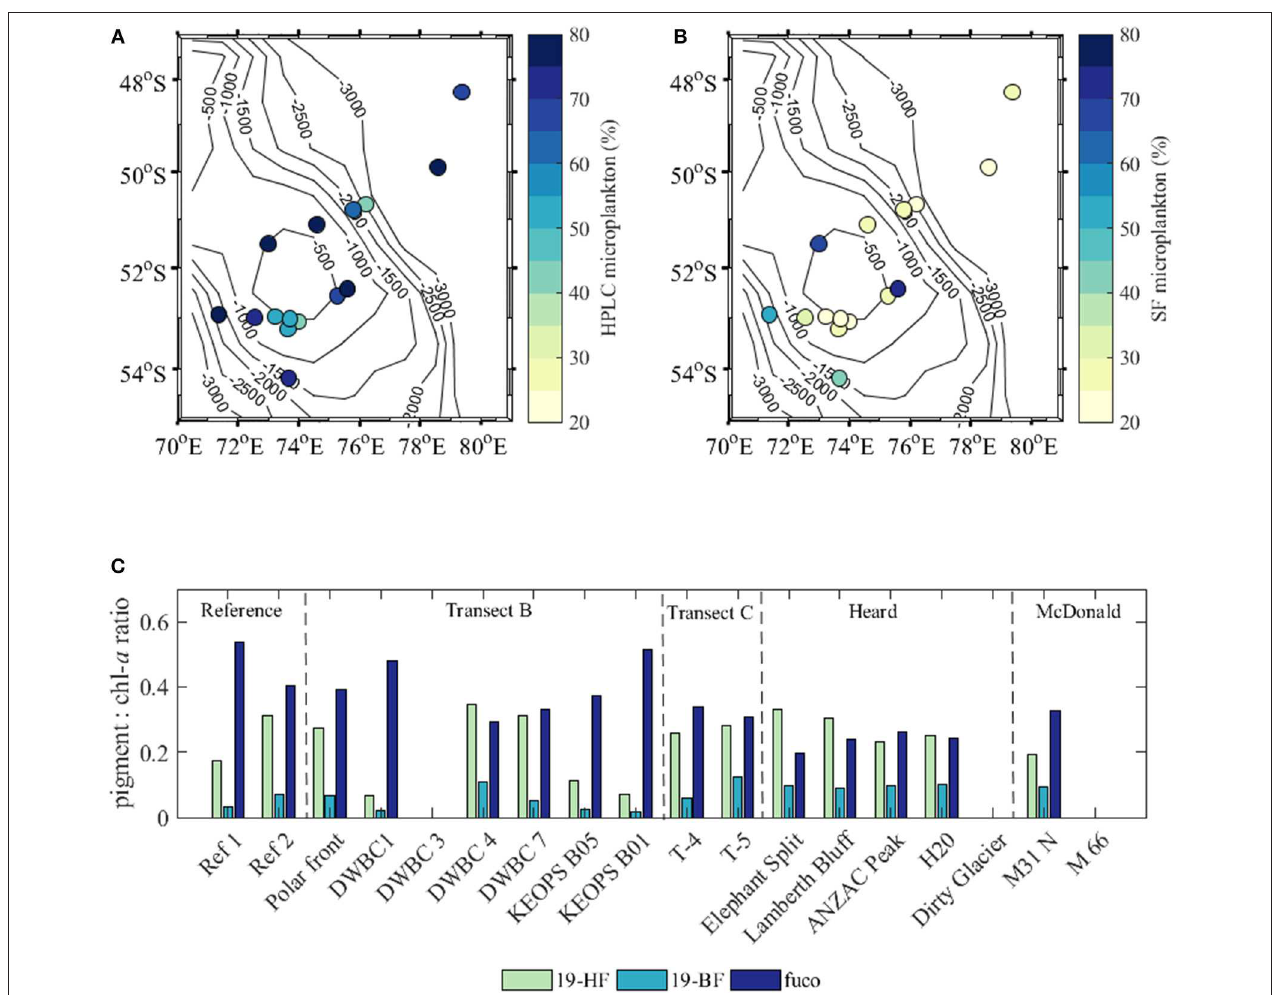
FIGURE 4 | Contribution of microphytoplankton [as percentage (%)] to total phytoplankton biomass (A) using the Uitz et al. (2009) model based on the pigment concentration and (B) size-fractionated total chl- a data; (C) ratios of pigments 19 ′ -hexanoyloxyfucoxanthin (19-HF), 19 ′ -butanoyloxyfucoxanthin (19-BF), and fucoxanthin (fuco) to chlorophyll a concentration (chl- a ) in the < 20 µ m size fraction.